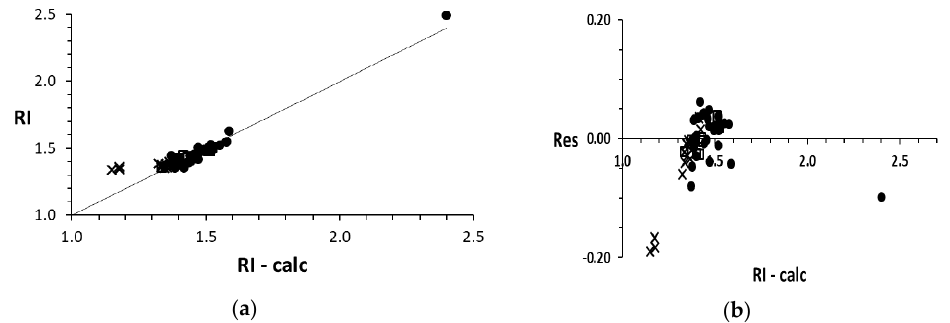
Figure 5. Plot of the Experimental vs. calculated (calc) refractive index, RI , ( a ) and the corresponding residual plot ( b ): ( • ) training points, ( (cid:3) ) test points, and ( × ) evaluated points. Statistics of EV points: N = 14, r 2 = 0.96, s =